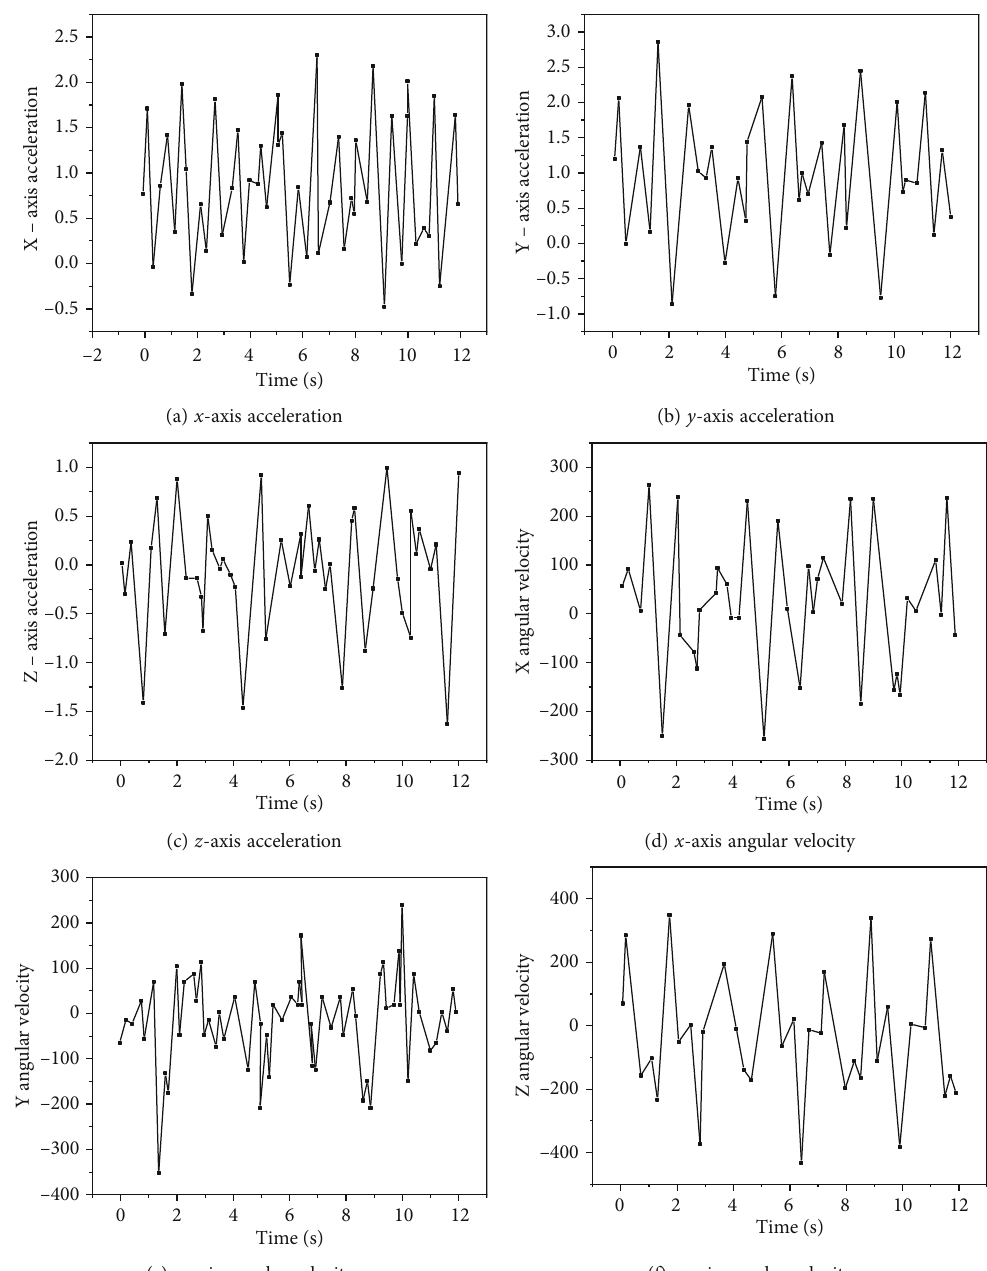
Figure 6: Waveform comparison of three-axis acceleration and angular velocity